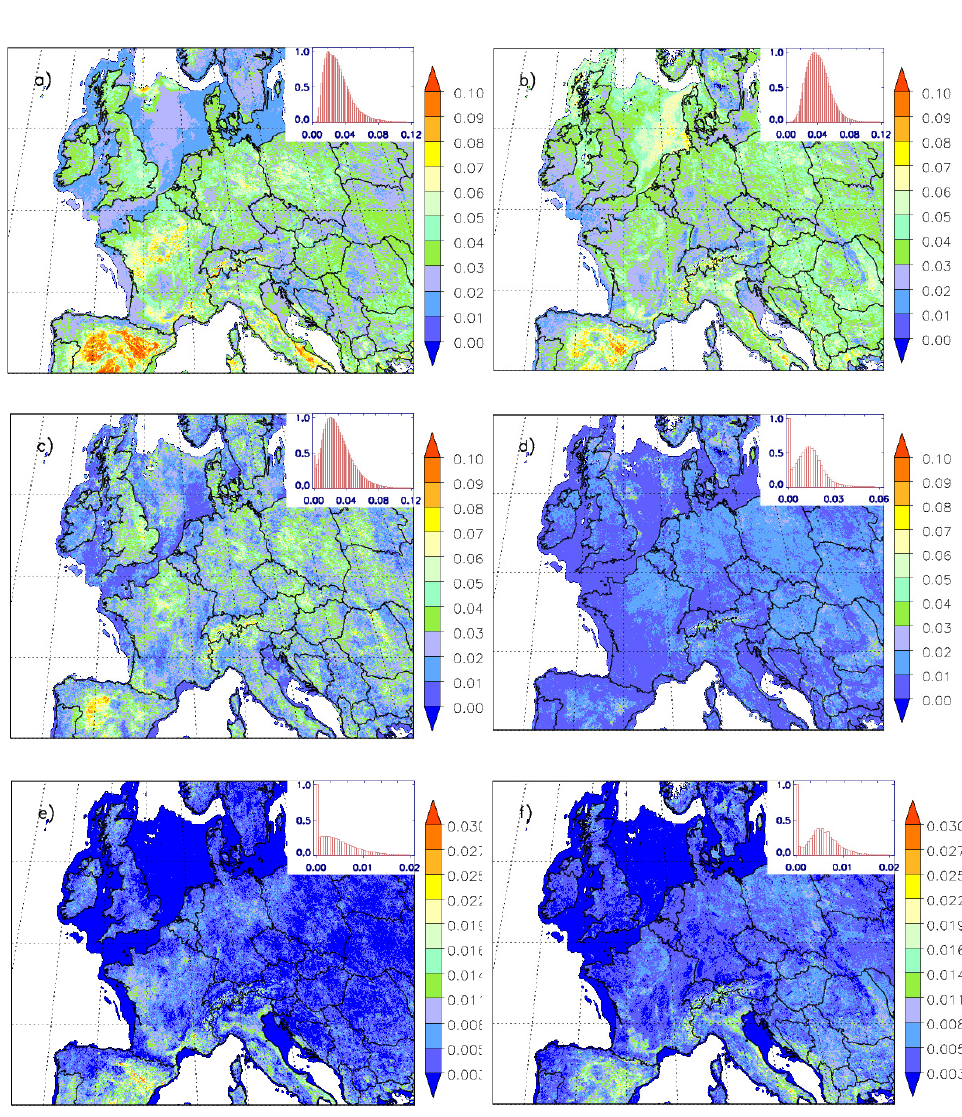
Fig. 4. Monthly mean maps for snow-free pixels in July (left column) and November (right column) 2006 of (a) and (b) f iso , (c) and (d) f vol , and (e) and (f) f geo from MODIS MCD43B1. The insets show the corresponding normalized frequency distributions.